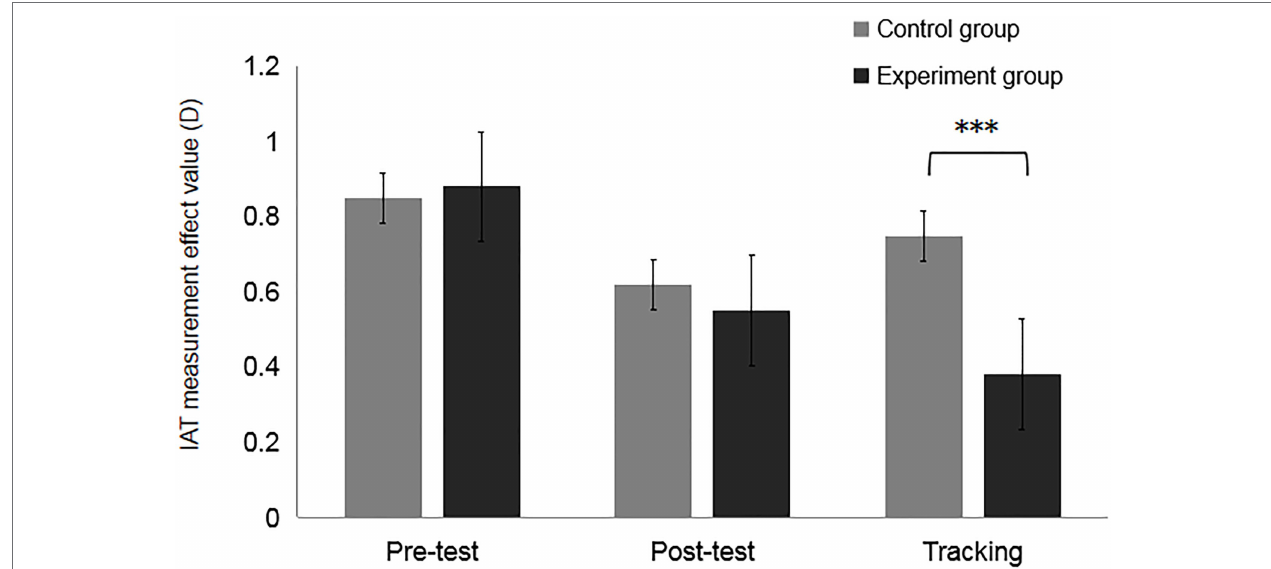
FIGURE 7 | Results of the measurement of the effect value of training effect (D) for different groups, *** p <